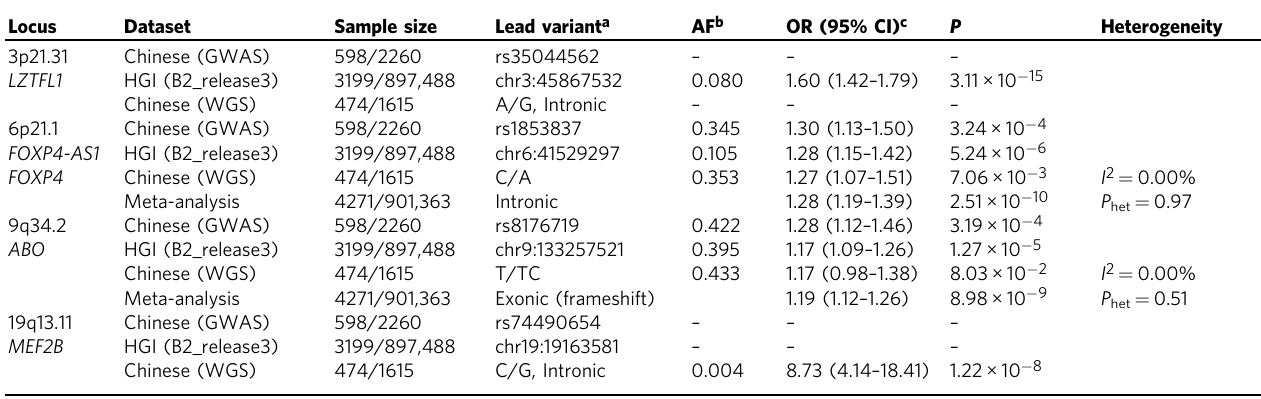
Table 2 Signi fi cant loci associated with COVID-19